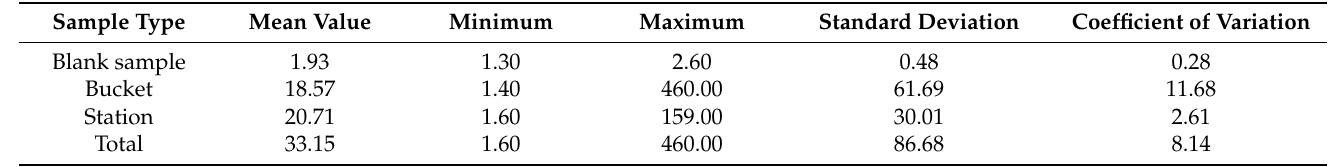
Table 5. Soil surface mercury content levels (unit: ng/g).